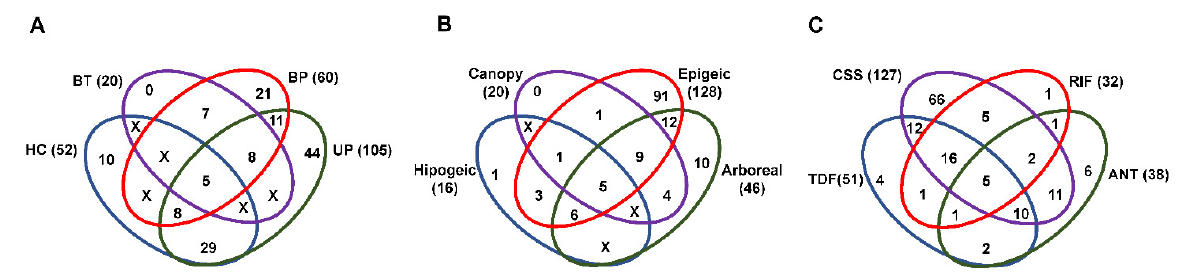
Fig 3 . Diagrams representing the number of shared and exclusive species according to: (A) sampling methods, (B) strata and (C) habitats. Different colors represent different methods, strata, and habitats. BT = Beating, HC = Hand collection, BP = Baited pitfall traps, UP = Unbaited pitfall traps, RIF = Riparian Forest, ANT = Anthropogenic habitats, TDF = Tropical Dry Forest, CSS = Cerrado sensu stricto . X represents that is no occurrence of ants in the intersection.